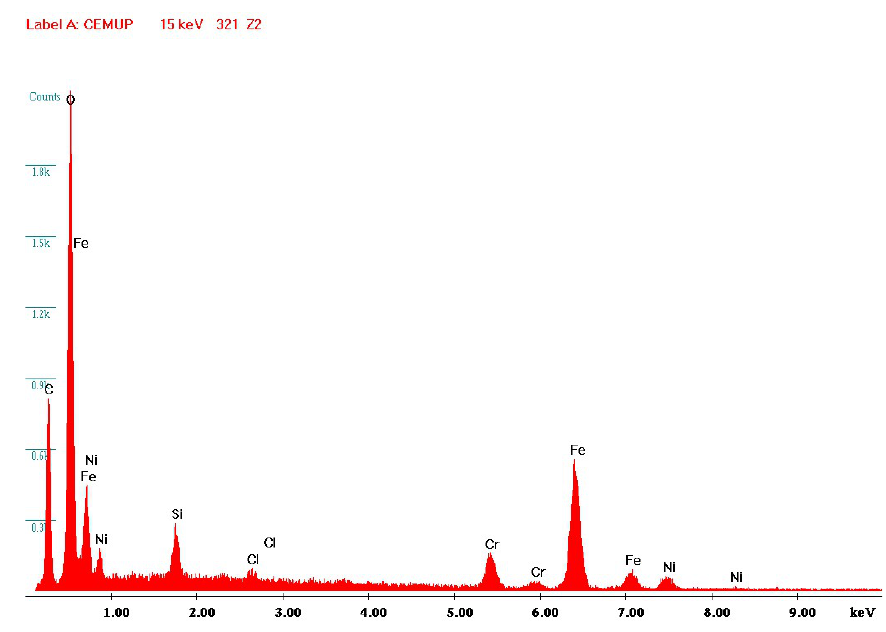
Figure A3. EDS of the red zone in the second AISI 321 SEM image.